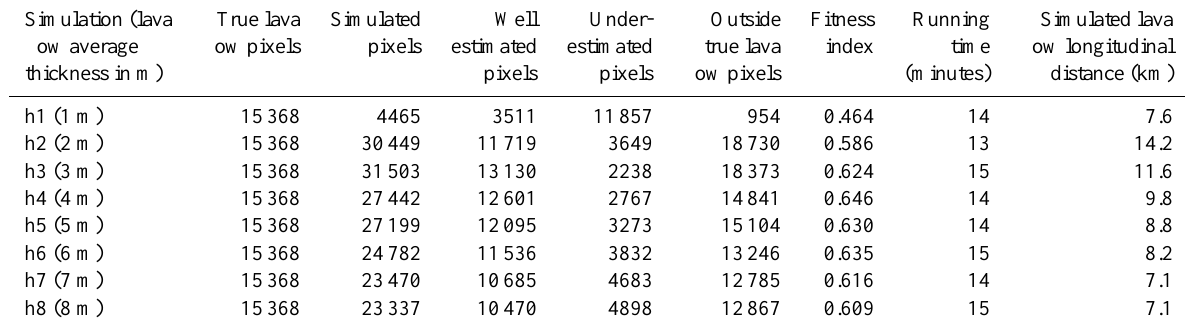
Table 4. Influence of the DEM used for the simulation of the 2010 lava flow of Nyamulagira. Simulation True lava Simulated Well Under- Outside Fitness Running (DEM) flow pixels pixels estimated estimated true lava index time pixels pixels flow pixels (minutes) S1 15368 31402 10820 2274 18308 0.587 S2 5122 17652 1645 45 15962 0.538 9 S3 15880 704 831 14821 228 0.229 16